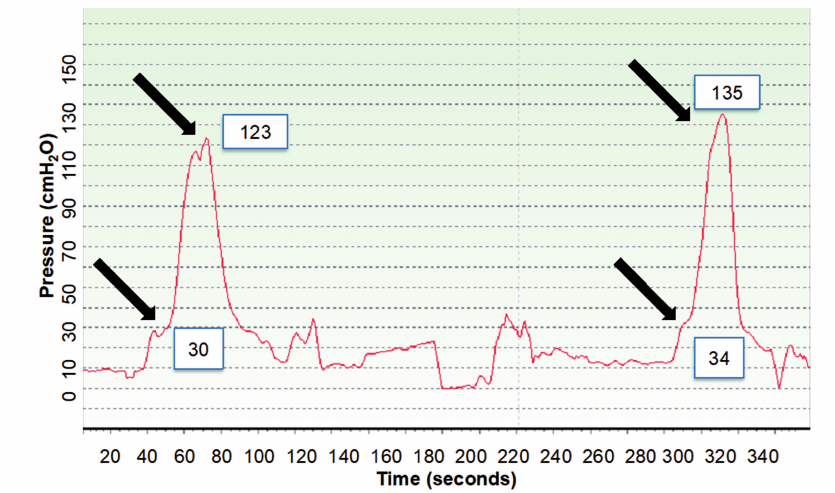
Figure 1 - SPAR (bottom arrow) immediately before the voluntary contraction that leads to SPUC (top